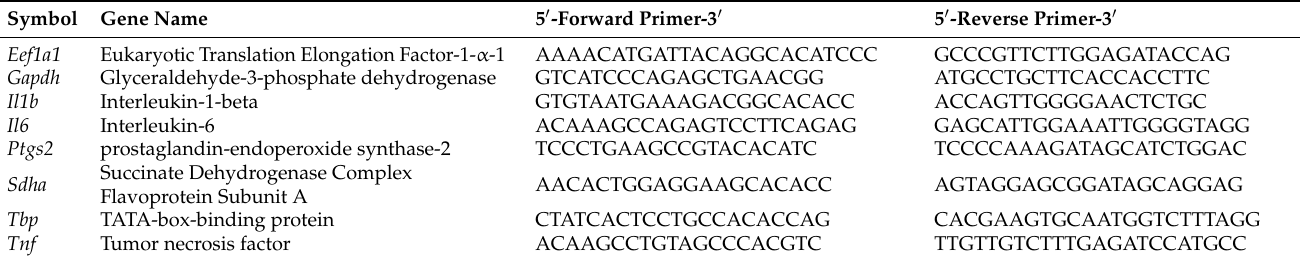
Table 1. Primer sequences for reference genes (pressure: Eef1a1/Sdha ; tension: Gapdh/Tbp ) and target